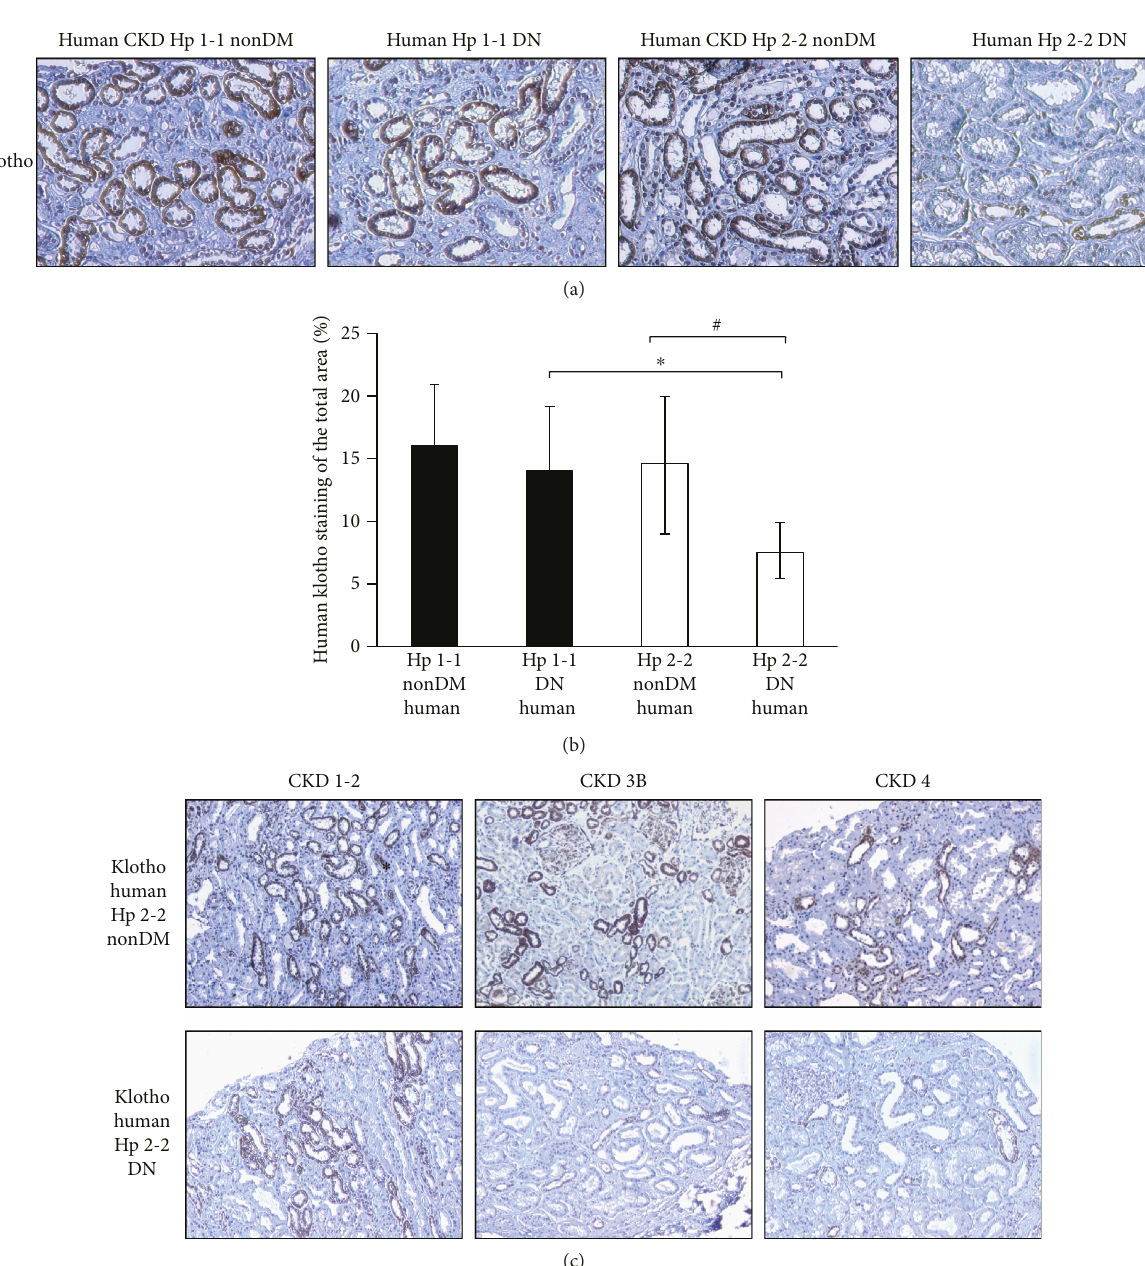
Figure 4: (a) α -Klotho renal expression in nondiabetic and diabetic nephropathy patients. (b) The percentage of the stained area of α -klotho is signi fi cantly decreased in the renal tubules of diabetic (DM) biopsies with Hp 2-2 genotype compared with Hp 1-1 diabetic ( ∗ p < 0 05 ) or with nondiabetic (nonDM) Hp 2-2 genotype ( # p < 0 05 ). (c) In chronic kidney disease (CKD) patients with the Hp 2-2 genotype, the renal expression of α -klotho declines with the progression in the CKD stage, and it is exacerbated in the diabetic